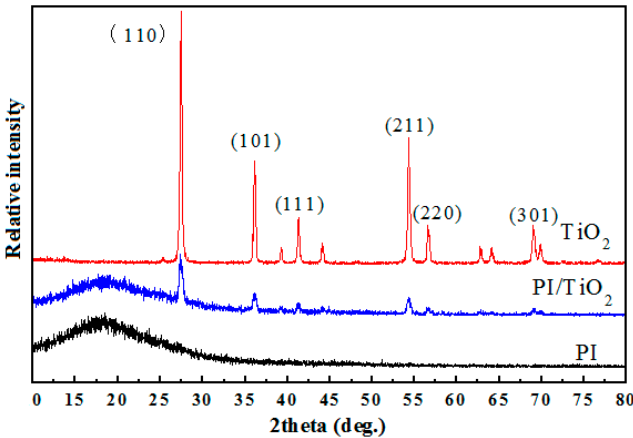
Figure 3. XRD diffraction data of polyimide (PI), TiO 2 , and PI/TiO 2 composite material.